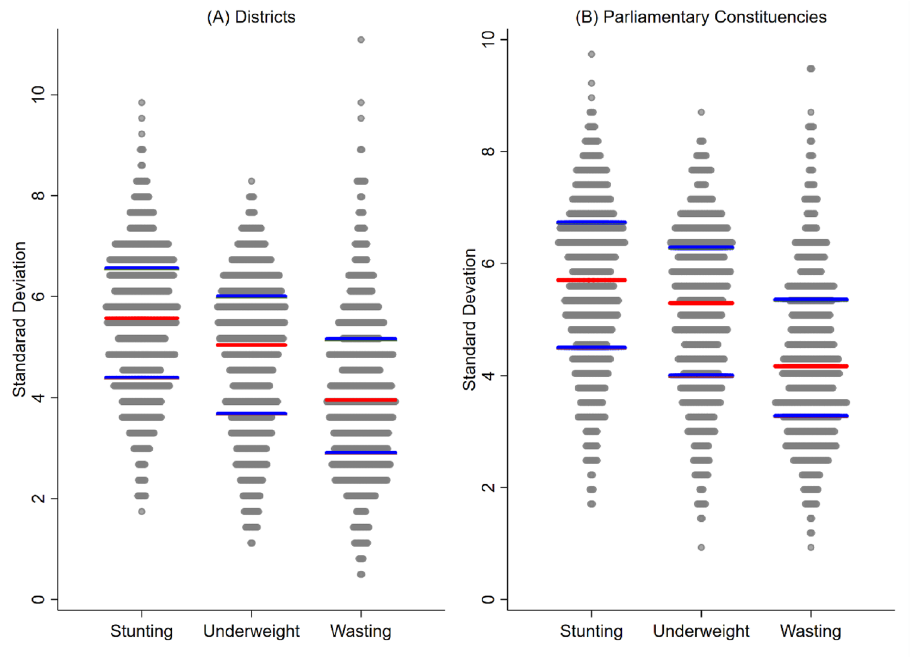
Figure 2. Dot plots showing distribution of standard deviations (SDs) of child anthropometric failures within ( A ) districts; ( B ) parliamentary constituencies. Note : Red lines represent median SD and blue lines represent 25th and 75th percentiles of